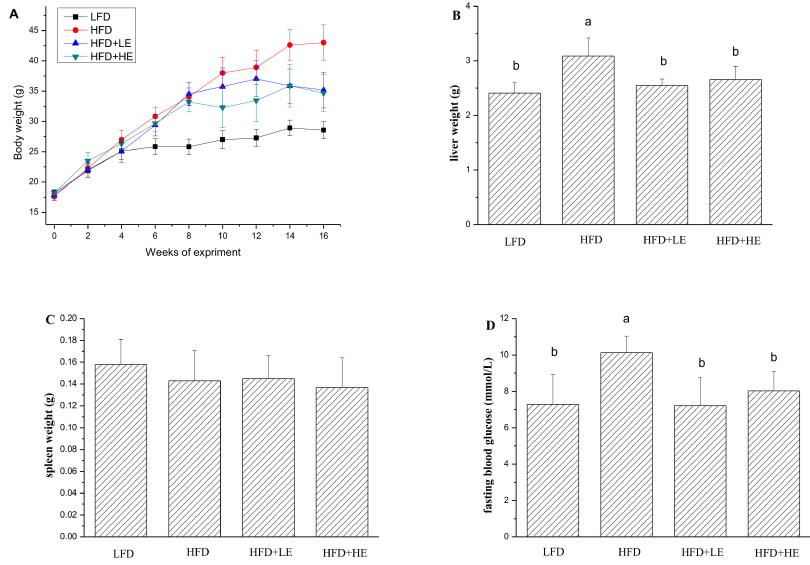
Figure 1. Effects of SCPE on fasting body weight ( A ), liver weight ( B ), spleen weight ( C ) and fasting blood glucose ( D ) of mice. Different lower-case letters correspond to significant differences at p <